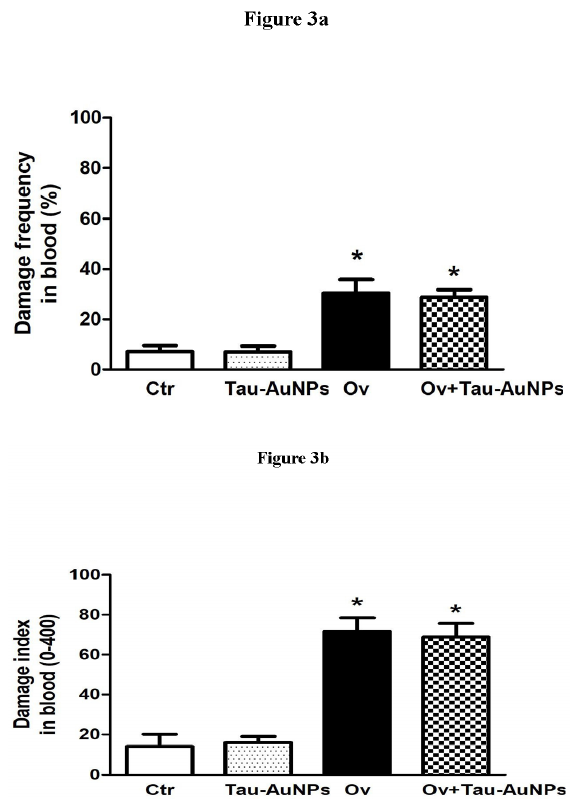
Figure 3. DNA damage in the blood of mice submitted to muscle overuse and Tau-AuNPs administration. The DNA damage frequency (a) and index (b) were expressed as the mean and SEM and were analyzed by one-way ANOVA followed by the post-hoc Bonferroni All statistical analyses were performed using Graph Pad Prism 7 software. Groups: control (Ctrl), tau-AuNPs, overuse (Ov), overuse plus tau-AuNPS